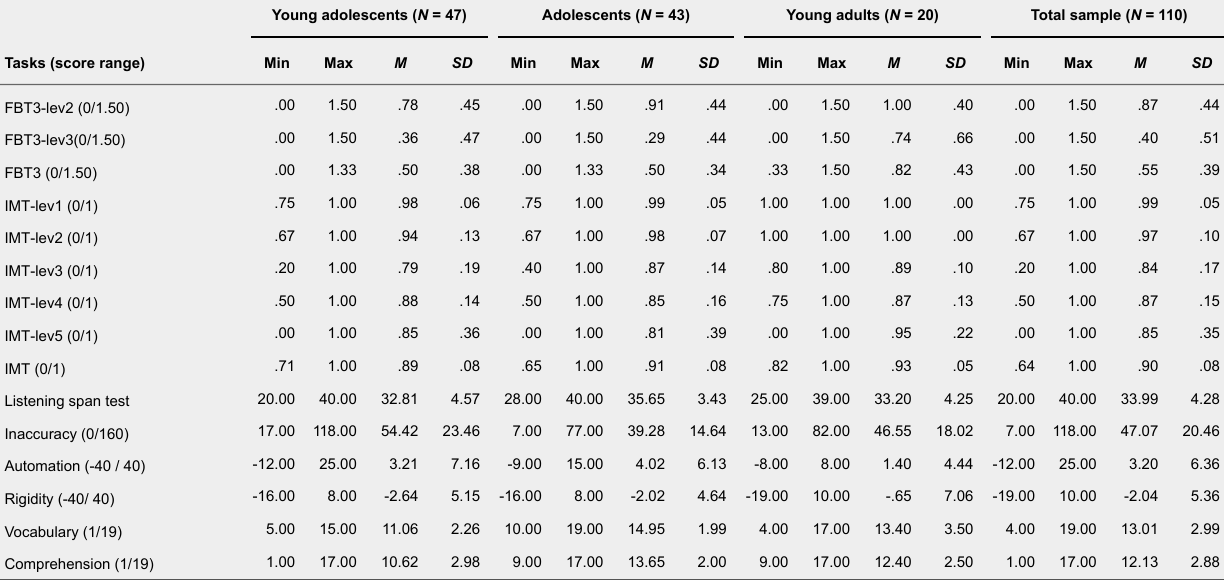
Descriptive Statistics of Task